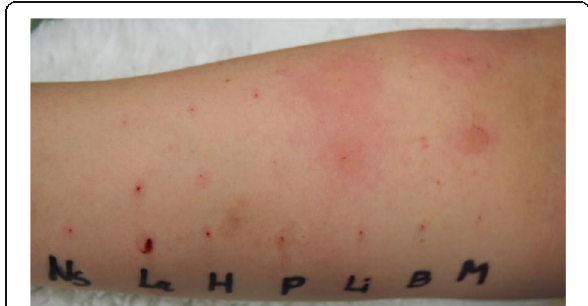
Fig. 2 Skin prick test. NS saline, La latex, H hydroxyethylated starch, P procaine, L lidocaine, B bupivacaine, M mepivacaine. Positive reaction to lidocaine and